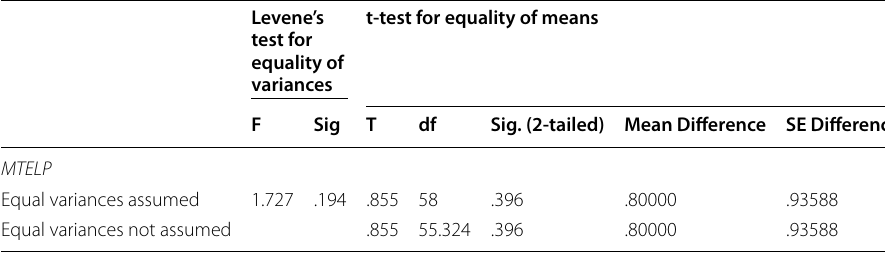
Levene’s test for equality of